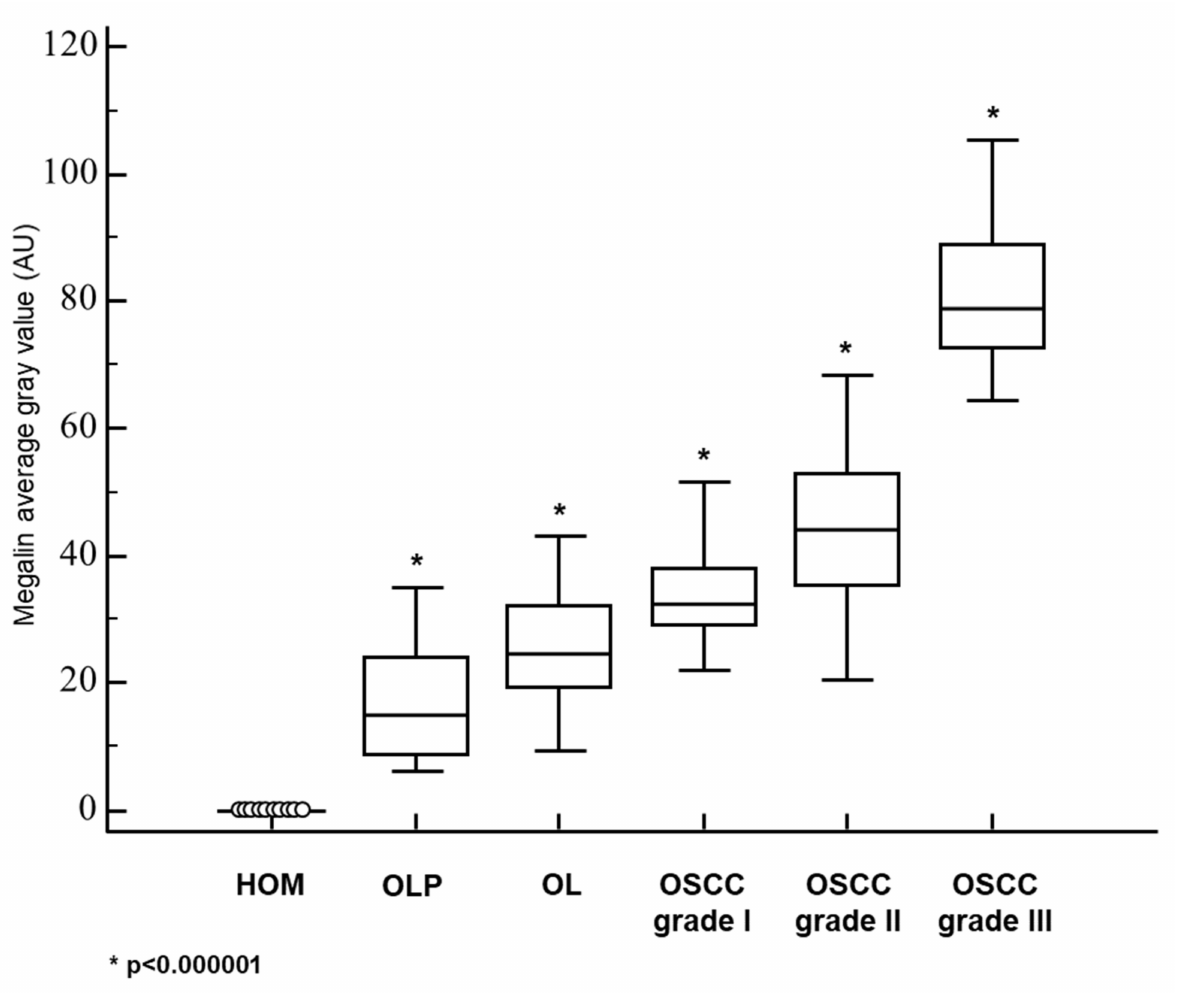
Figure 4. Quantified megalin staining intensities in premalignant and malignant oral squamous epithelial lesions. The measurements were made by ImageJ software and data are expressed in arbitrary units (AU) as the median of average gray values with range. HOM, healthy oral mucosa; OLP, oral lichen planus; OSCC, oral squamous cell carcinoma. * p < 0.000001 when each group is compared to the